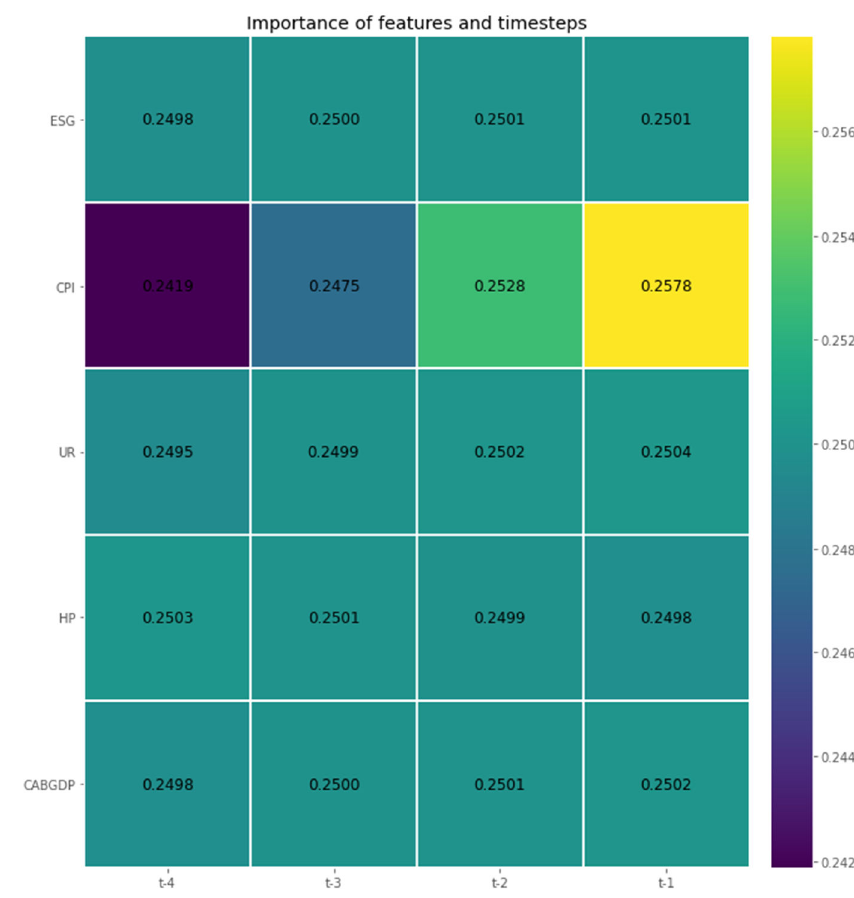
Figure 5. Importance of features and